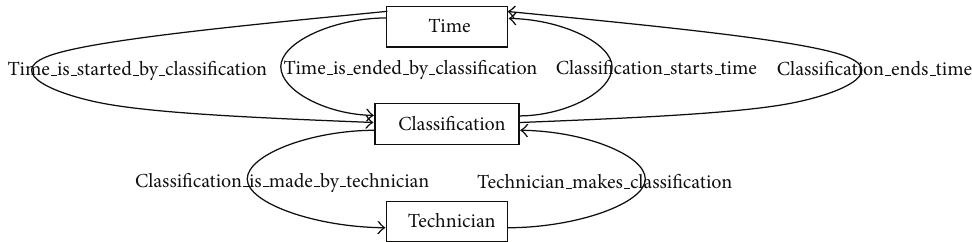
Figure 5: Classification is temporal information carried out by